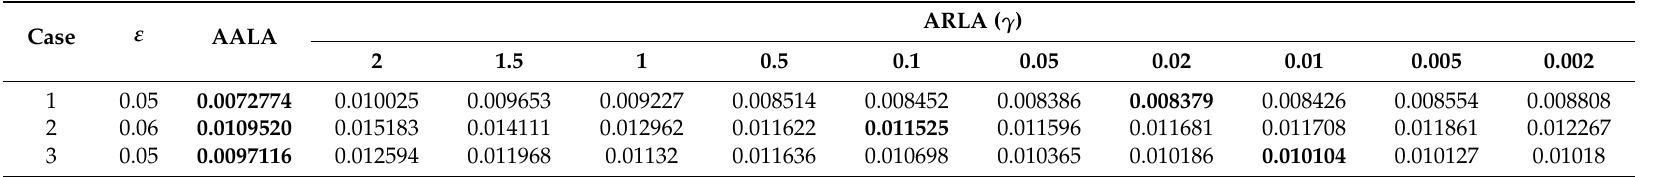
Table 2. Results of RMSE in (6) of the ARLA (0.002 ≤ γ ≤ 2) and AALA after 1000 training epochs for three